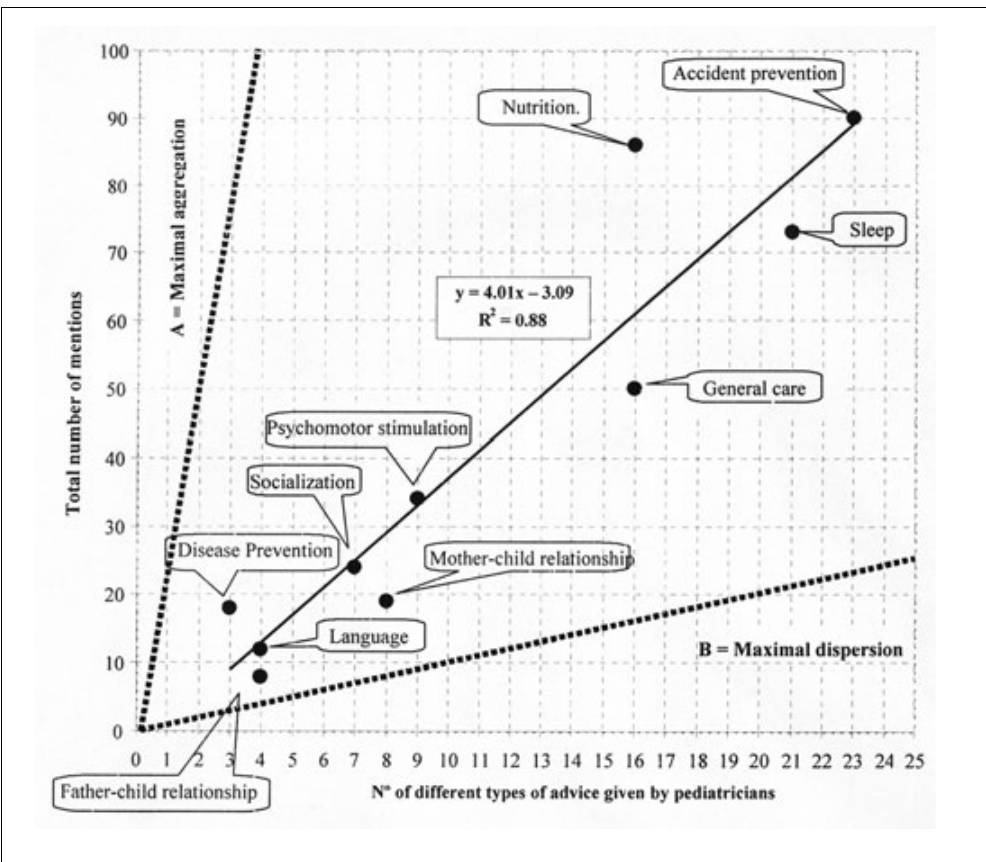
Figure 6. Number of mentions and different types of advice given by